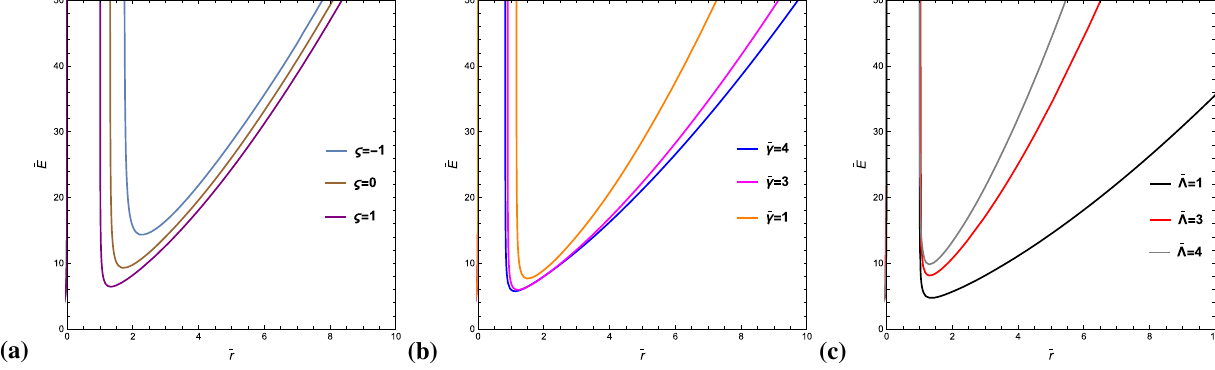
Fig. 3 The graphs show the specific energy ¯ E to ¯ r for the particles moving around the black hole and making the thin accretion disk. a Different values of ς with considering ¯ γ = 2 and ¯ Λ = 2. b Different values of ¯ γ with considering ς = 1 and ¯ Λ = 2. c Different values of ¯ Λ with considering ς = 1 and ¯ γ =